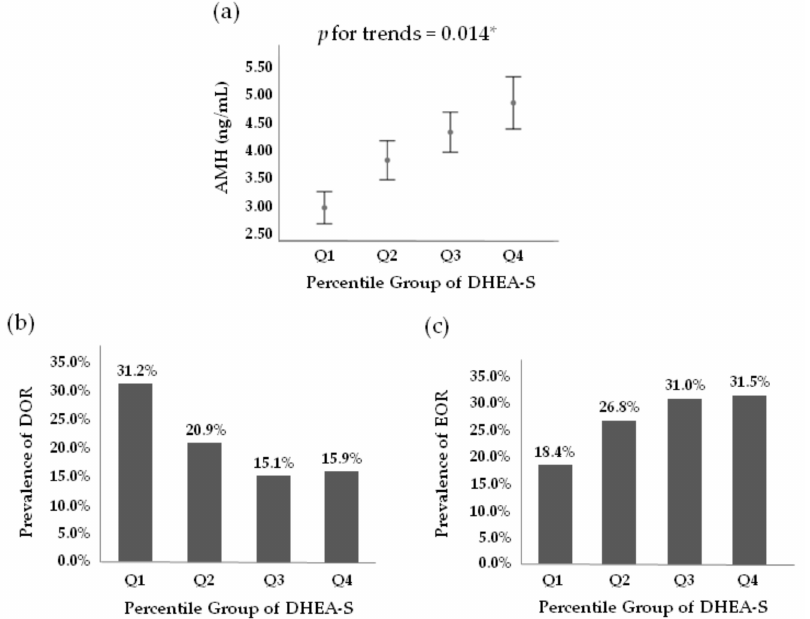
Figure 2. Correlations between serum DHEA-S quartile categories and AMH levels. ( a ) Serum AMH levels significantly increased across the increasing DHEA-S quartile categories. * The p -value for the trends was generated using generalized linear models after adjustment for potential confounders including age, BMI, FSH, and prolactin. Error bars represent 95% confidence interval of serum AMH levels; ( b ) prevalence of diminished ovarian reserve (DOR) according to serum DHEA-S quartile categories. DOR was defined as serum AMH levels < 1.2 ng/mL; ( c ) prevalence of excess ovarian reserve (EOR) based on serum DHEA-S quartile categories. EOR was defined as serum AMH values ≥ 5.0 ng/mL. AMH, anti-Mullerian hormone; DHEA-S, dehydroepiandrosterone sulphate; Q, quartile